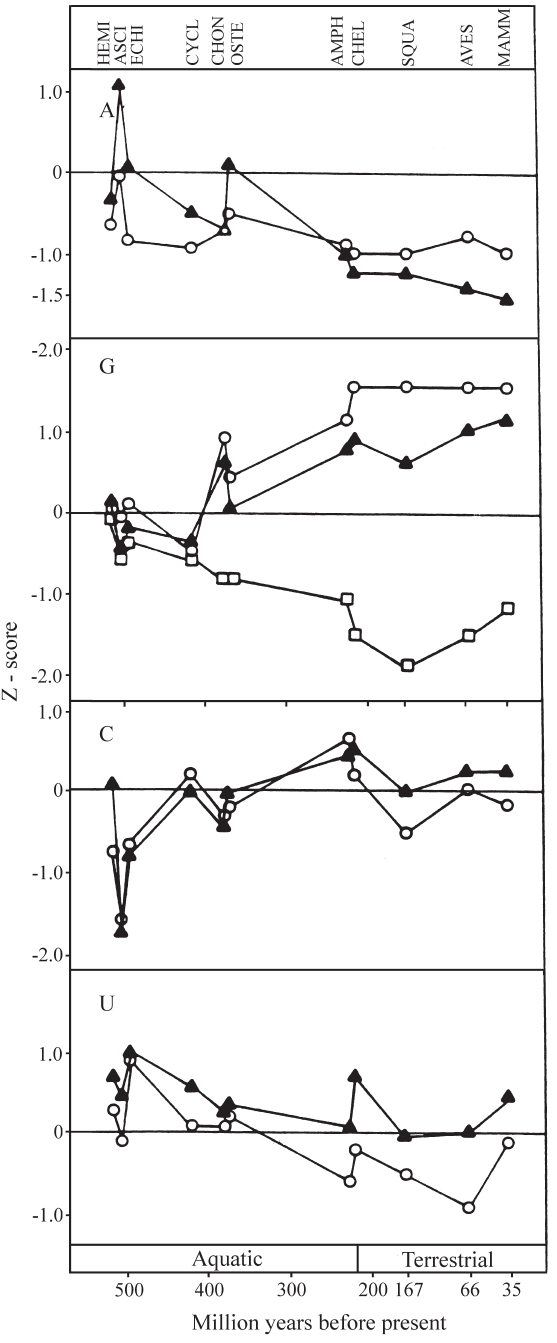
Figure 1 - Frequency of bases and dinucleotides in the 5S rRNA of deuterostomes vs . paleontology dating. Total of a base ( ∆ ), isolated G (K); dinucleotides (O) and z-scores calculated as in Material and Methods. HEMIchordates, ASCIdian, ECHInoderms, CYCLostomes, CHONdri- chtians, OSTEichthians, AMPHibians, CHELonian, SQUAmate, MAM- Malians.